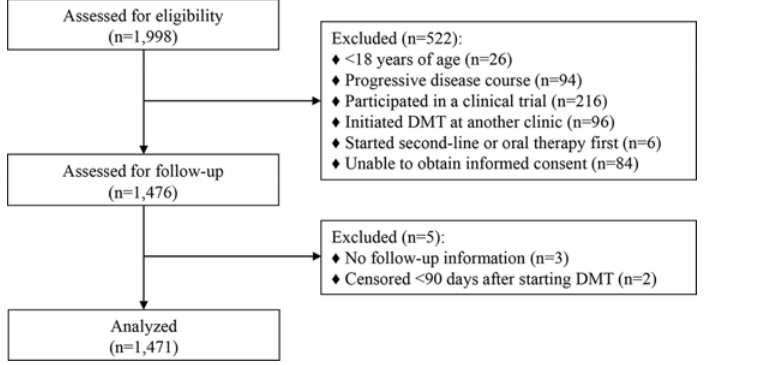
Fig 1. Flow diagram of patient selection into the study